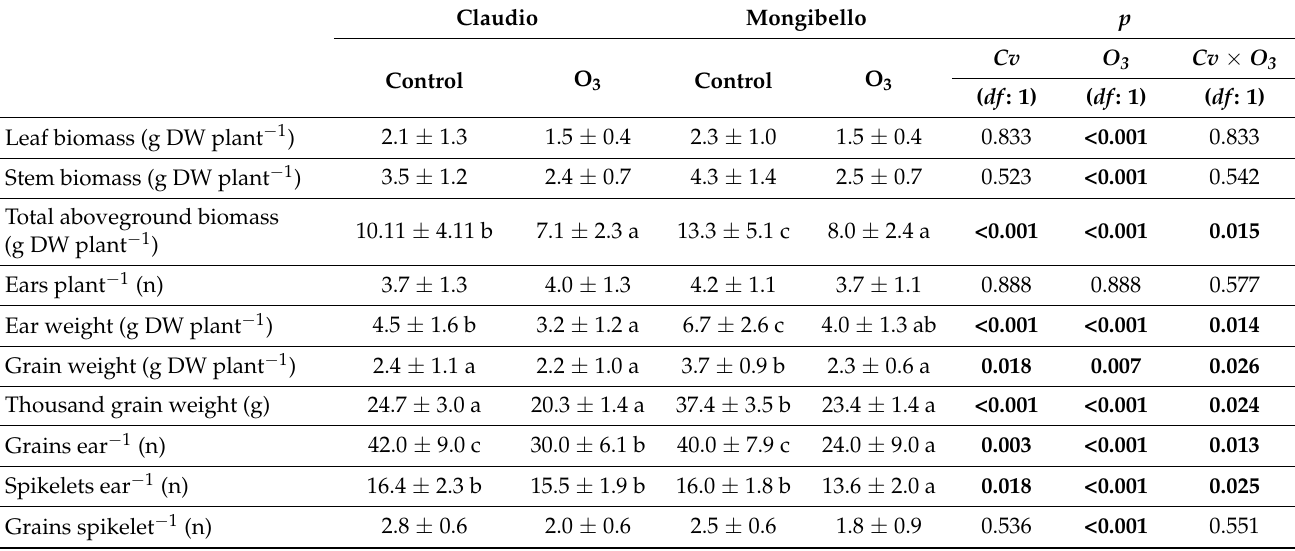
Table 1. Biomass and yield parameters in wheat cultivars Claudio and Mongibello exposed to